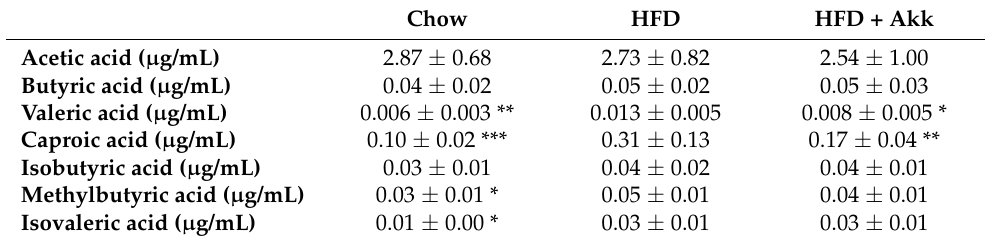
Table 1. Plasma levels of short-chain fatty acids.